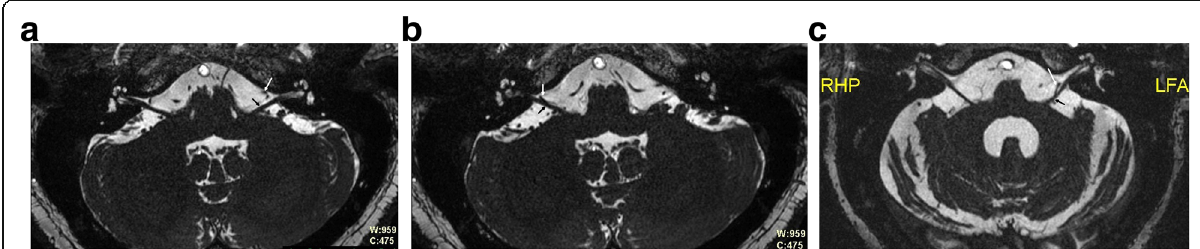
Fig. 2 Different types of vascular contact in CISS images of the CPA and IAC with white arrows pointing to the vascular loop and the black arrows pointing to the corresponding 8th cranial nerve. ( a ) no contact, ( b ) direct contact, and ( c ) direct contact with mild